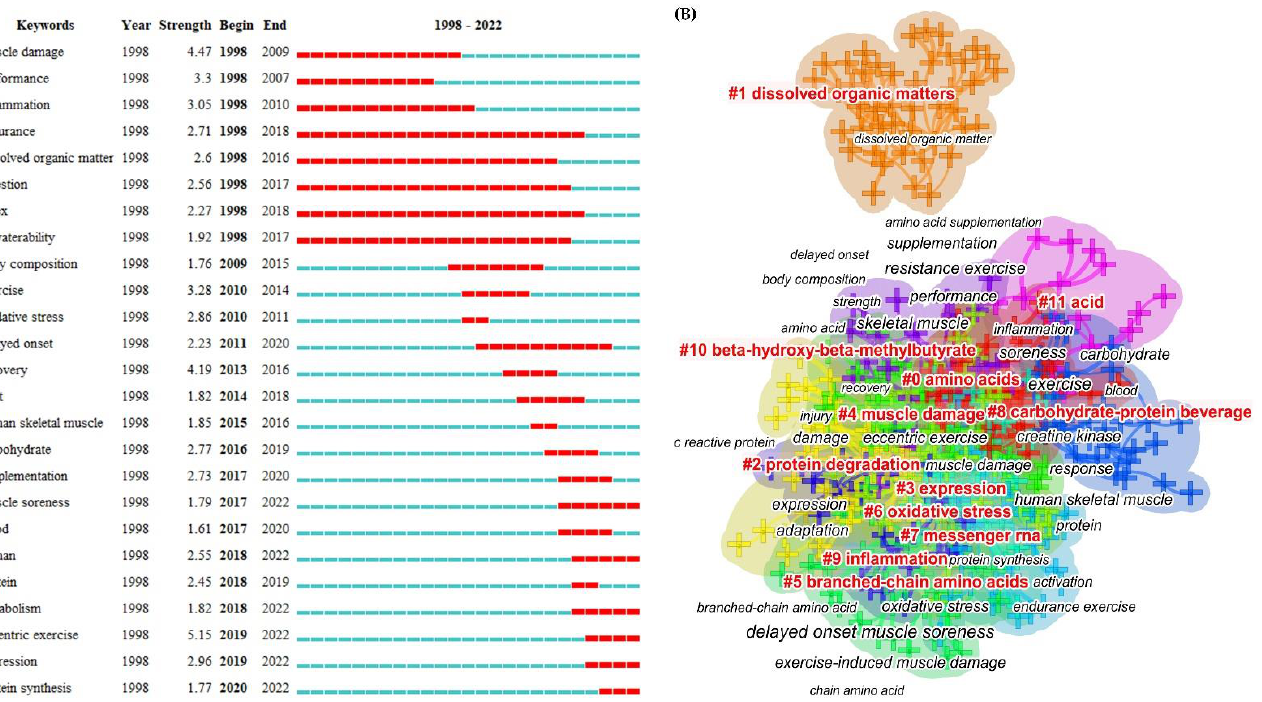
Figure 7. Keyword visualization of frequency and centrality, strongest citation bursts, and cluster mapping. ( A ) Top 25 keywords with the strongest citation bursts; ( B ) the keyword clustering map. Note: Begin, start time of keyword burst; End, end time of keyword burst. Legend: ▂ one year; ▃ burst year. Black font indicates representative co-cited references; red font with # indicates cluster labels and cluster names of co-cited references.